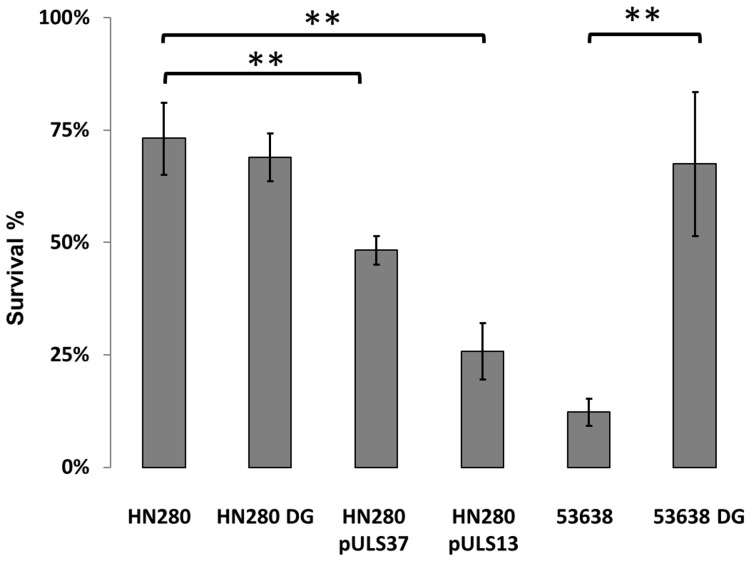
Effect of speG on the sensitivity to oxidative stress.The sensitivity to H2O2 was assayed on EIEC strain HN280 (wild type), on its speG-deleted derivative HN280DG, on HN280 complemented with a plasmid carrying speG under the control of its own promoter (pULS37) or of the Ptac promoter (pULS13), on strain 53638 (wild type), and on its speG defective derivative 53638 DG. Survival in the presence of H2O2 was measured after exposure of strains, grown in M9 complete medium, to H2O2 for 1 h at 37°C. The survival percentage is relative to growth without exposure to H2O2. Error bars indicate the standard deviations relative to at least three independent experiments. ** denotes p<0.05.